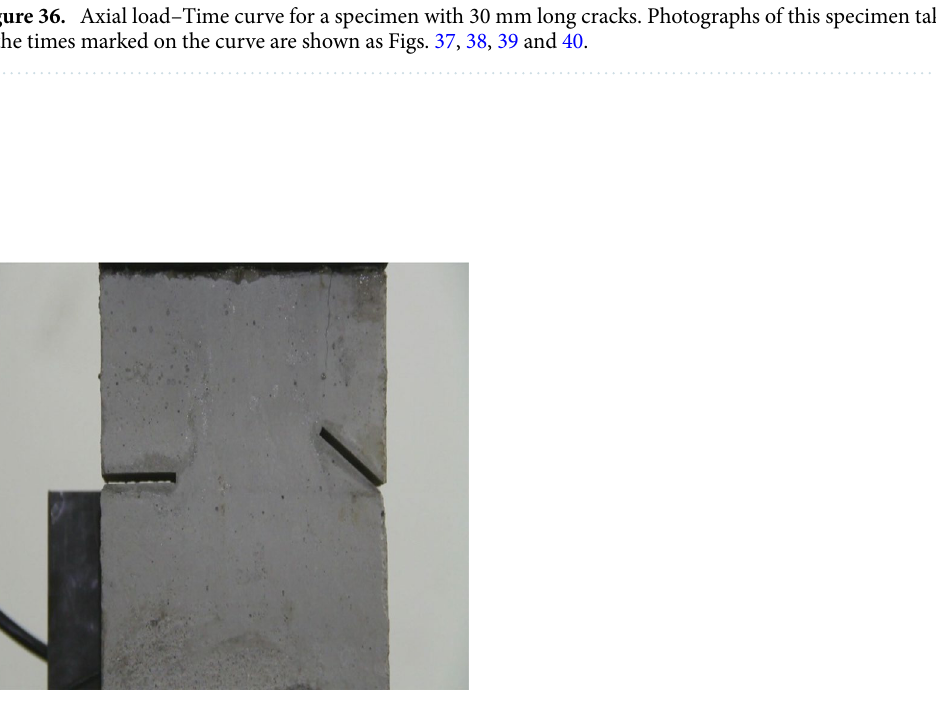
Figure 37. Photograph of a specimen with 30 mm long cracks under uniaxial compression at t = 919 s showing the crack developed at that